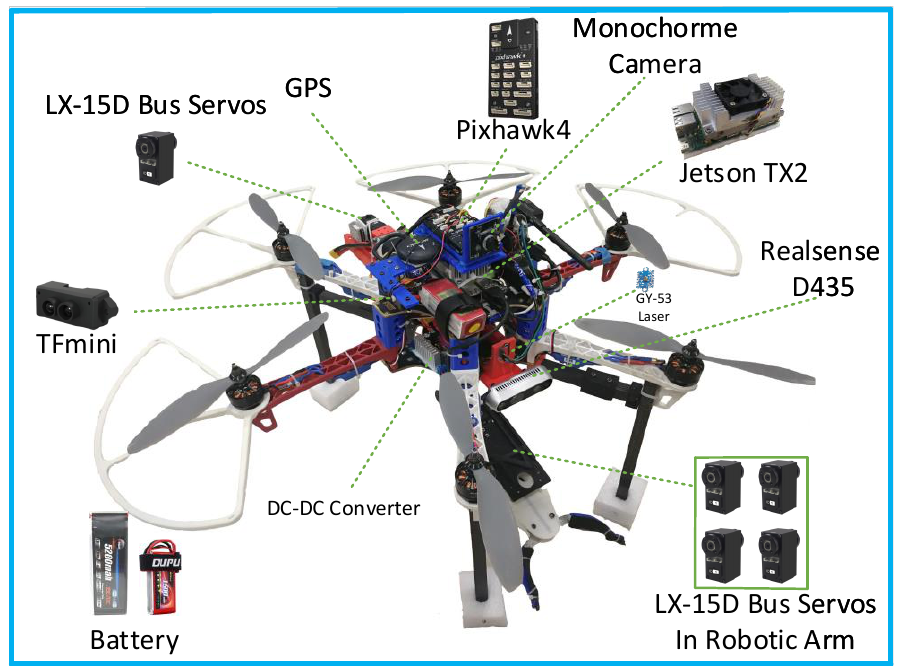
Figure 3. Hardware components of the Unmanned Aerial Manipulator